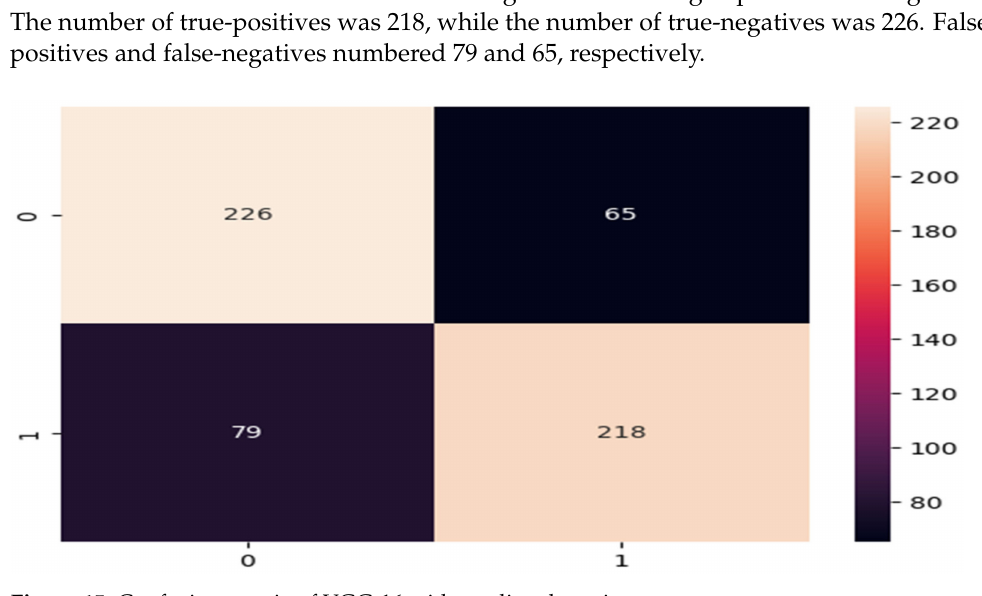
Figure 16. The number of true-positives was 73, and 218 images were classified as